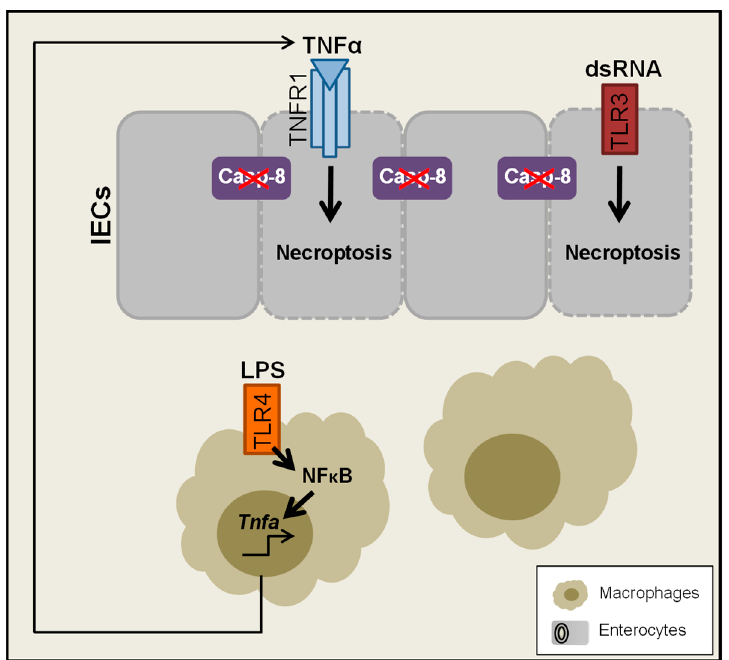
Figure 5. TNF α -dependent and independent TLR-mediated signalling in the gut. Administration of lipopolysaccharide (LPS) might activate TLR4 signalling in immune cells, to induce NF κ B and subsequently gene expression of Tnfa , which in turn mediates TNFR1-driven epithelial cell death. dsRNA might directly bind to TLR3 on epithelial cells to trigger cell death, independently of TNFR1- signaling.